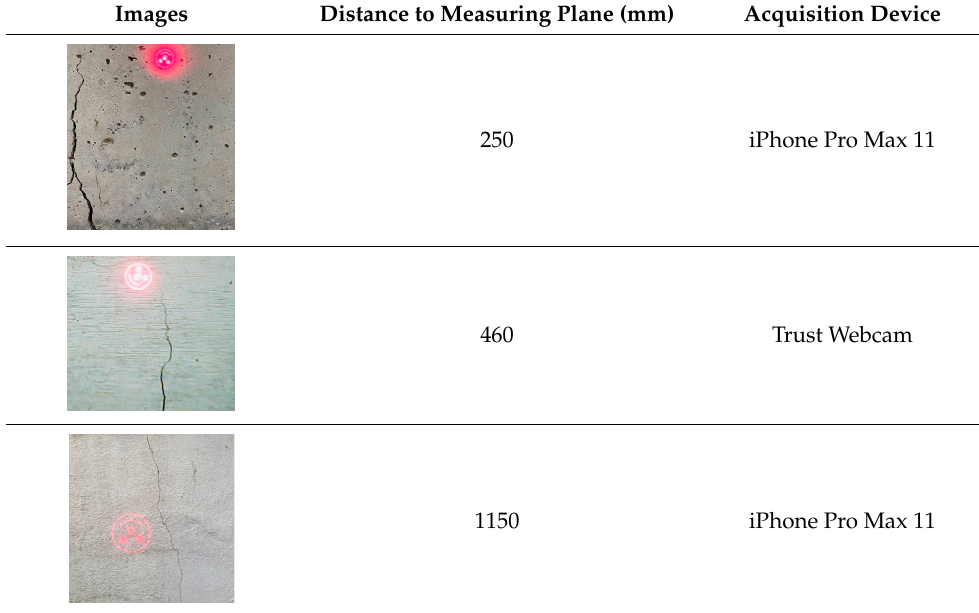
Table 1. Some of the images of cracks were captured using two different devices. Images